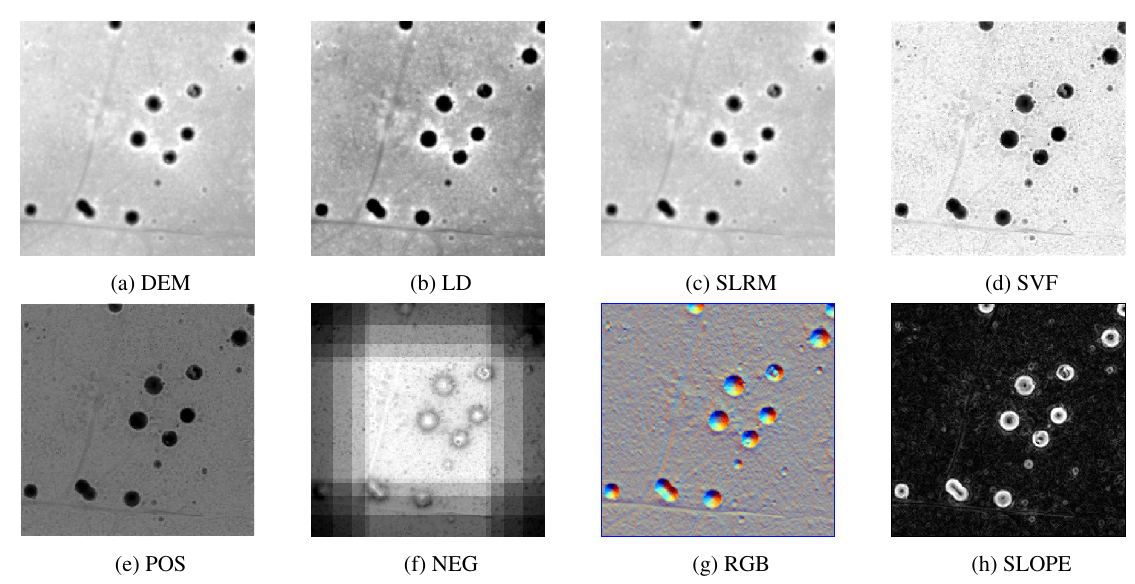
Figure 9. Examples of different raster derivatives for bomb craters from